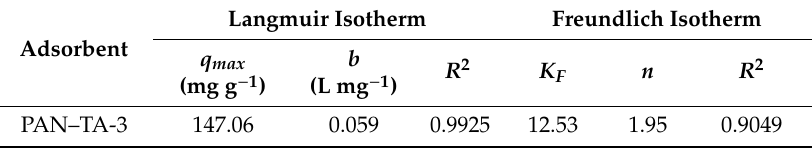
Table 2. Langmuir and Freundlich constants for Cr(III) adsorption on PAN–TA-3.